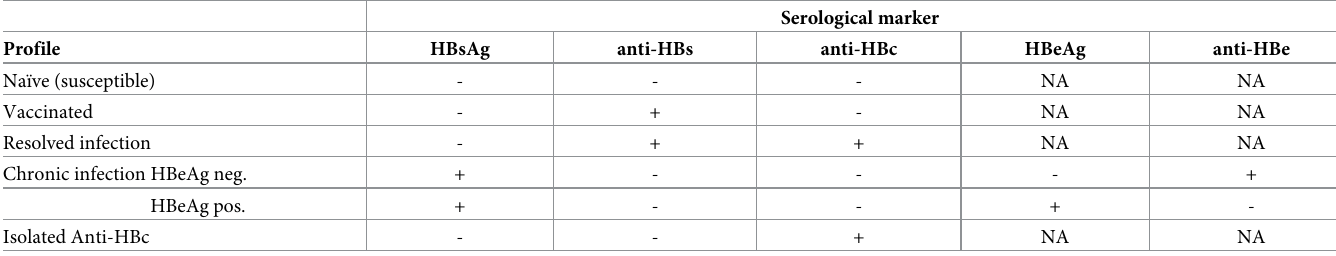
Table 1. Serological profiles of hepatitis B infection according to serological